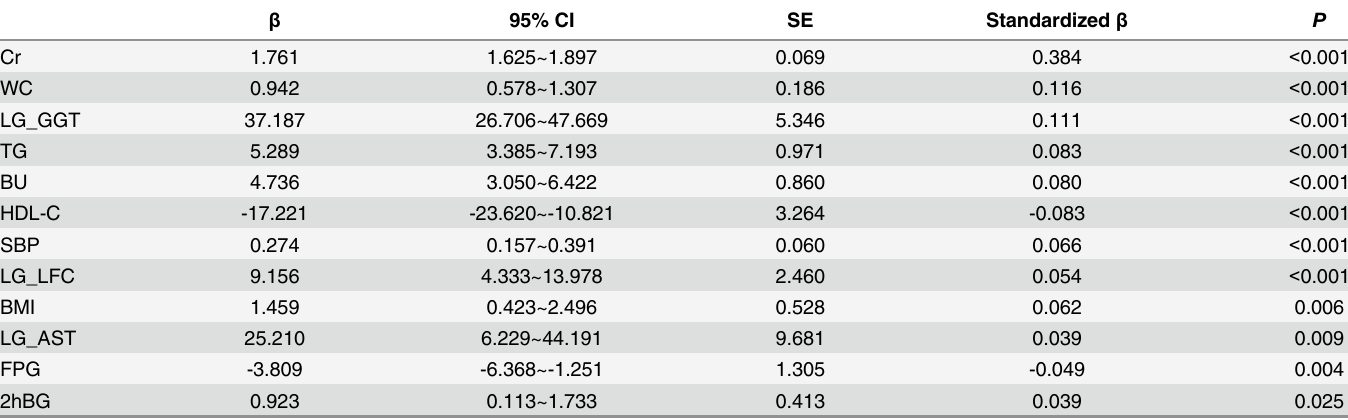
Table 3. Factors associated with the level of serum uric acid.